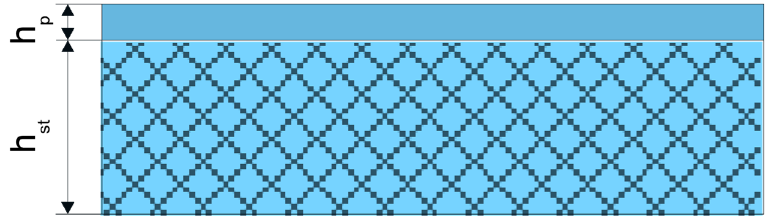
Figure 2. Scheme of the layer band layout prepared for the cold working process where h p is the thickness of the coating and h st is the height of the steel base.